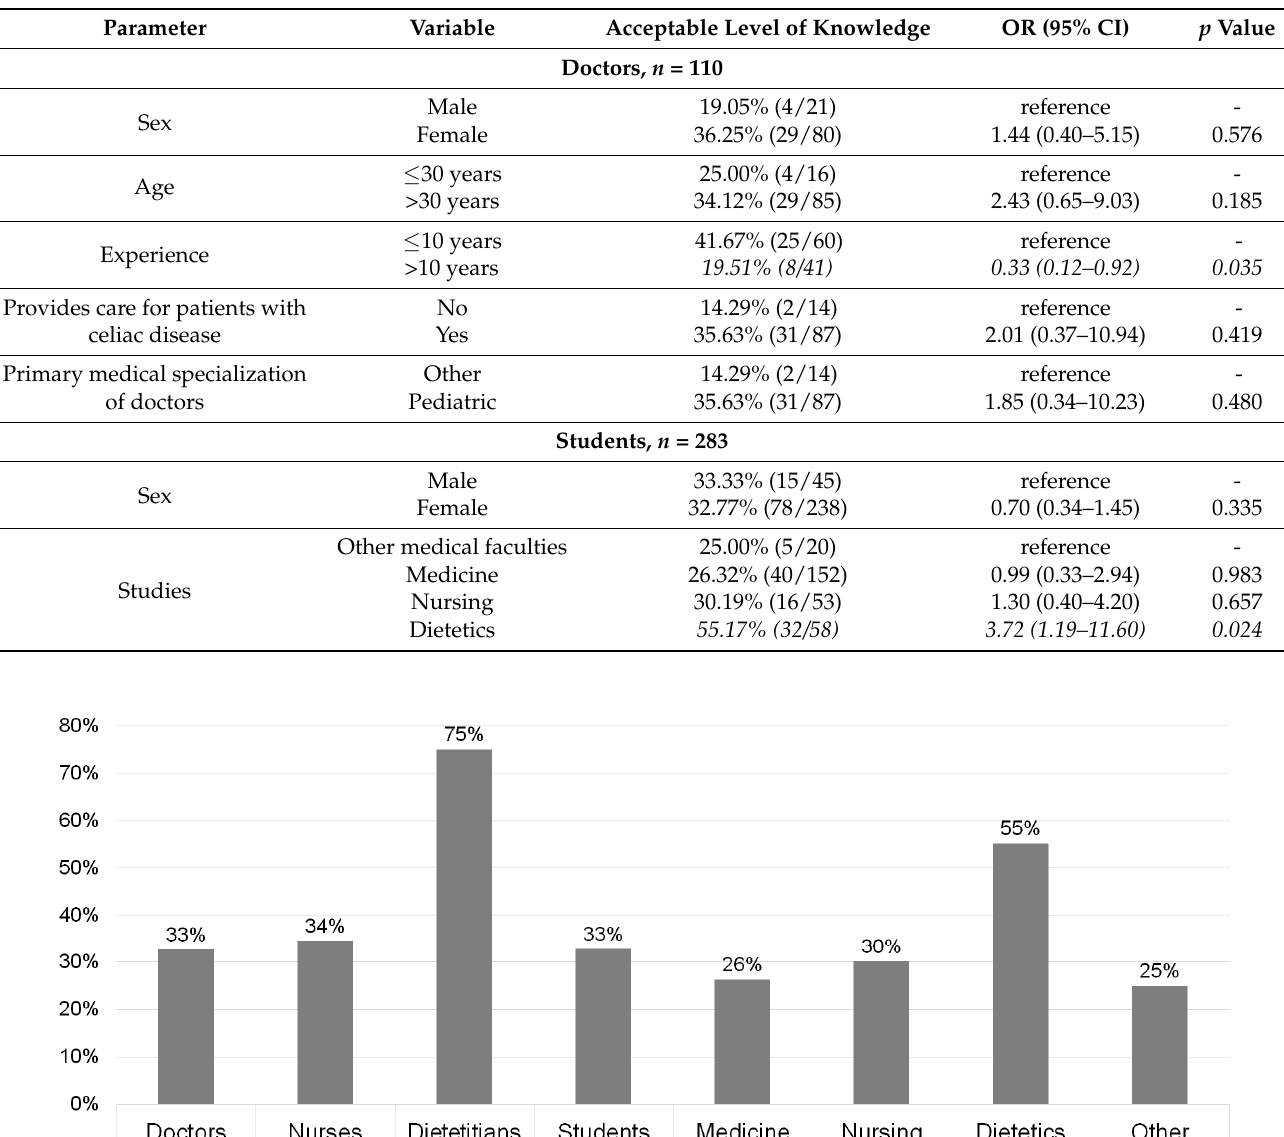
Table 3. Level of knowledge among study participants and odds ratios (OR) with 95% confidence interval (CI) (in pa-